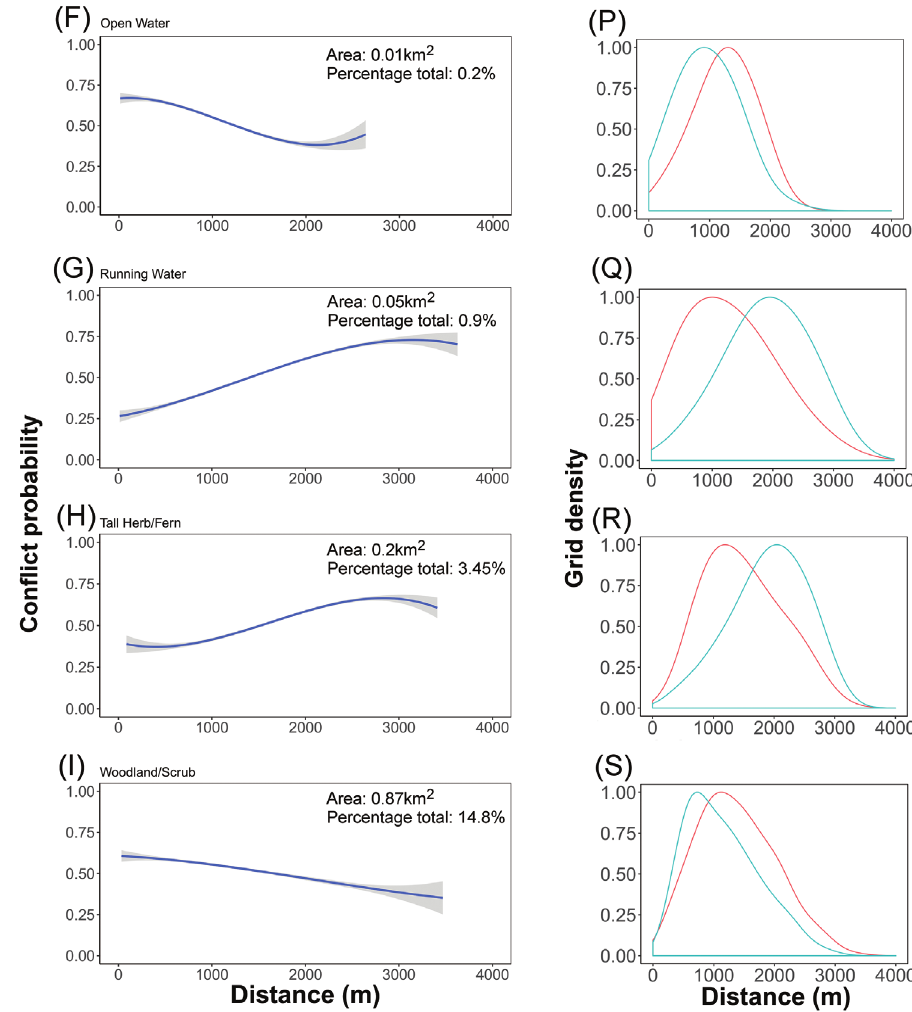
Figure 511. Continued. F–i human-deer ( Cervus elaphus ) probability modelled with distance to each feature. The 95% confidence intervals are shown in grey P–s Density distribution of randomly sampled high-encounter points (blue) and low-encounter points (red) modelled with distance to each feature. Data collected from Lyme Park, Disley, UK, in